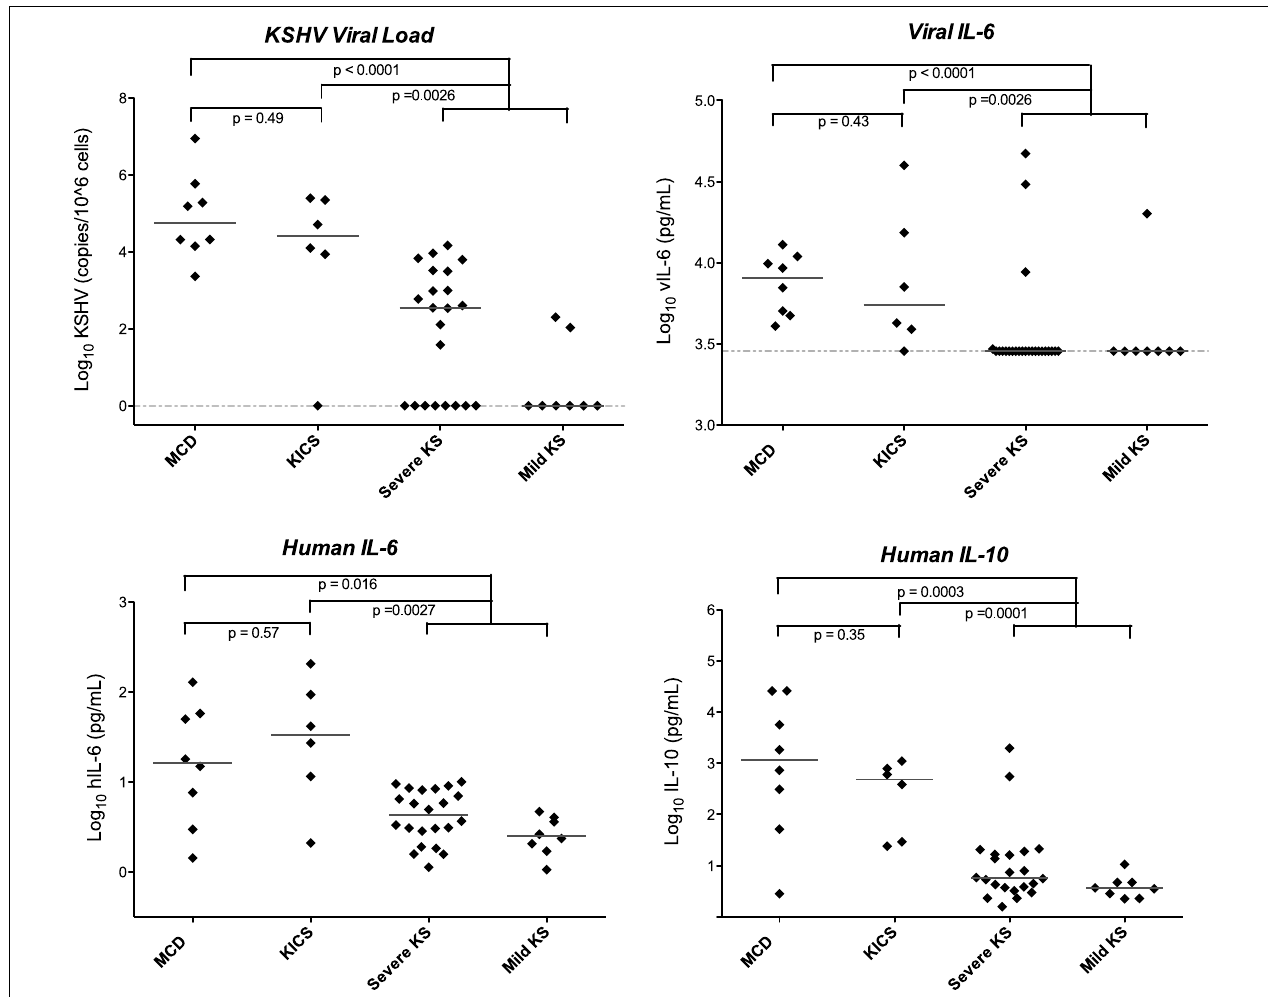
limit of detection.Values are log transformed; viral and human IL-6 and IL-10 are picograms per milliliter; KSHVVL is copies/10 6 cells. Note that several of the patients with severe KS and elevated vIL-6 had laboratory abnormalities suggestive of KICS, but did not meet the operative case definition for this series. Modified from Uldrick et al. (2010a), with